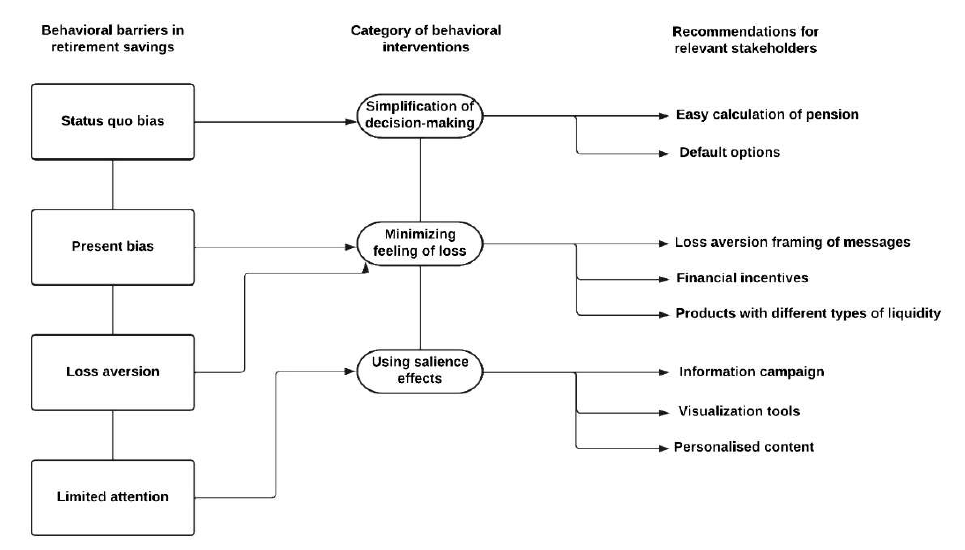
Figure 2. Framework of behavioral barriers and designed